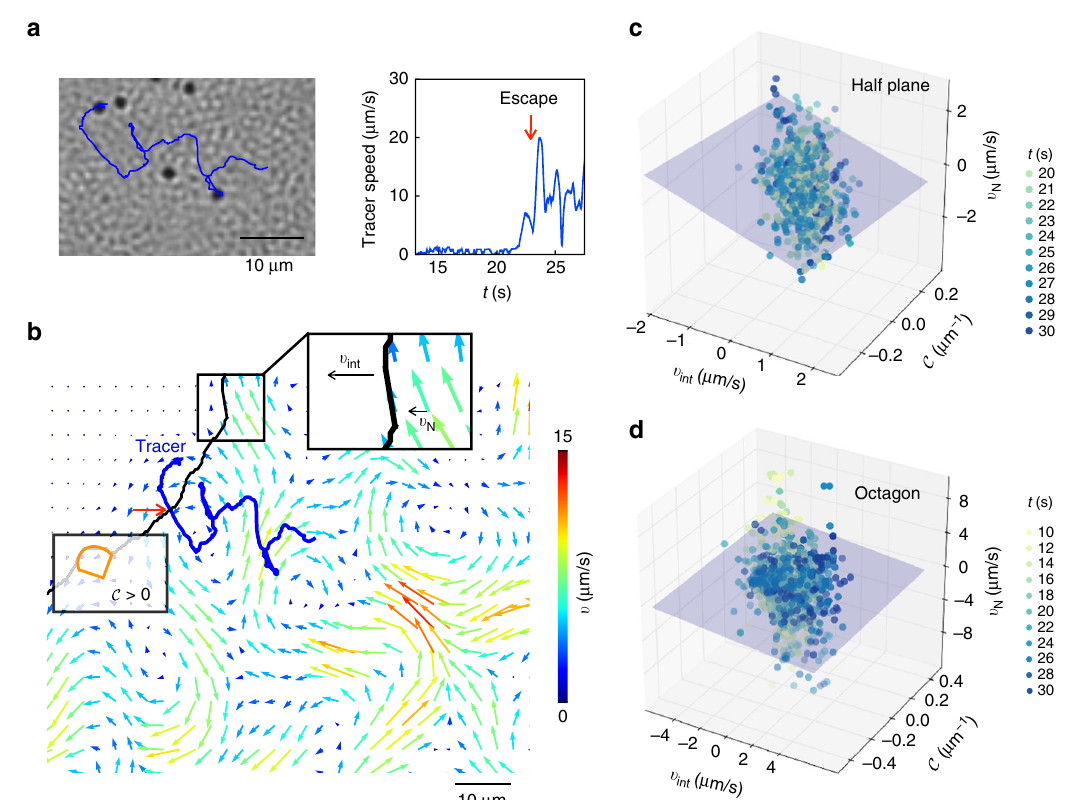
Fig. 4 Evolution of the active – passive interface follows an active analog to classical Gibbs – Thomson – Stefan conditions. a Particle motion at the interface. A representative trajectory of a 2 μ m polystyrene tracer particle reveals how the swarm extracts particles from the passive domain. First, particles in the passive phase caged-in by their neighbors do not move. Second, when the diffuse interphase is roughly a velocity correlation length O ( w v ) away, the trapped particle starts to fl uctuate, as seen in its speed over time. Third, agitations induced by the active particles dislodge the jammed tracer from the cage of neighboring passive particles. For the tracer in b the fl ow fi eld moves the particle tangentially along the interface (Supplementary Movie 6). Finally, the particle escapes the passive domain as normal streaming fl ows between adjacent vortices pull the particle away, primarily perpendicularly from the interface. This escape correlates with a rapid increase in particle speed; once inside the swarm, the speed of the tracer fl uctuates (red arrow). The schematic de fi nes the sign of the curvature and normal bacterial velocity. c , d Local interface velocity v int correlates with the interface curvature C and the normal component of the collective bacterial velocity v N at the interface. Data for v int , C , and v N collapses toward a plane for c half-plane [H] and d octagonal [O] aperture geometries; data shown here from representative experiments and gathered at 3 μ m spacings across the interface over a 10 – 20 s interval (Supplementary Note 5). The collapse of the data unto plane suggests the existence of an active analog of the classical Gibbs – Thomson – Stefan boundary conditions. Spatiotemporal analysis shown here was veri fi ed for a minimum of N = 2 experiments per